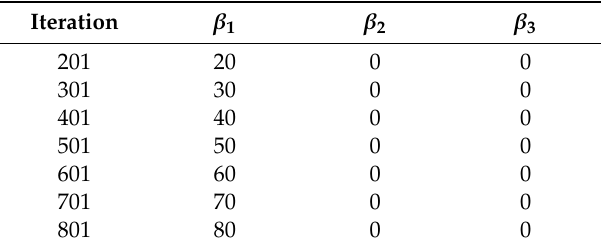
Table 4. Mixed skew angle selected test cases (from 1000 iterations seeking max. singularity free momentum).